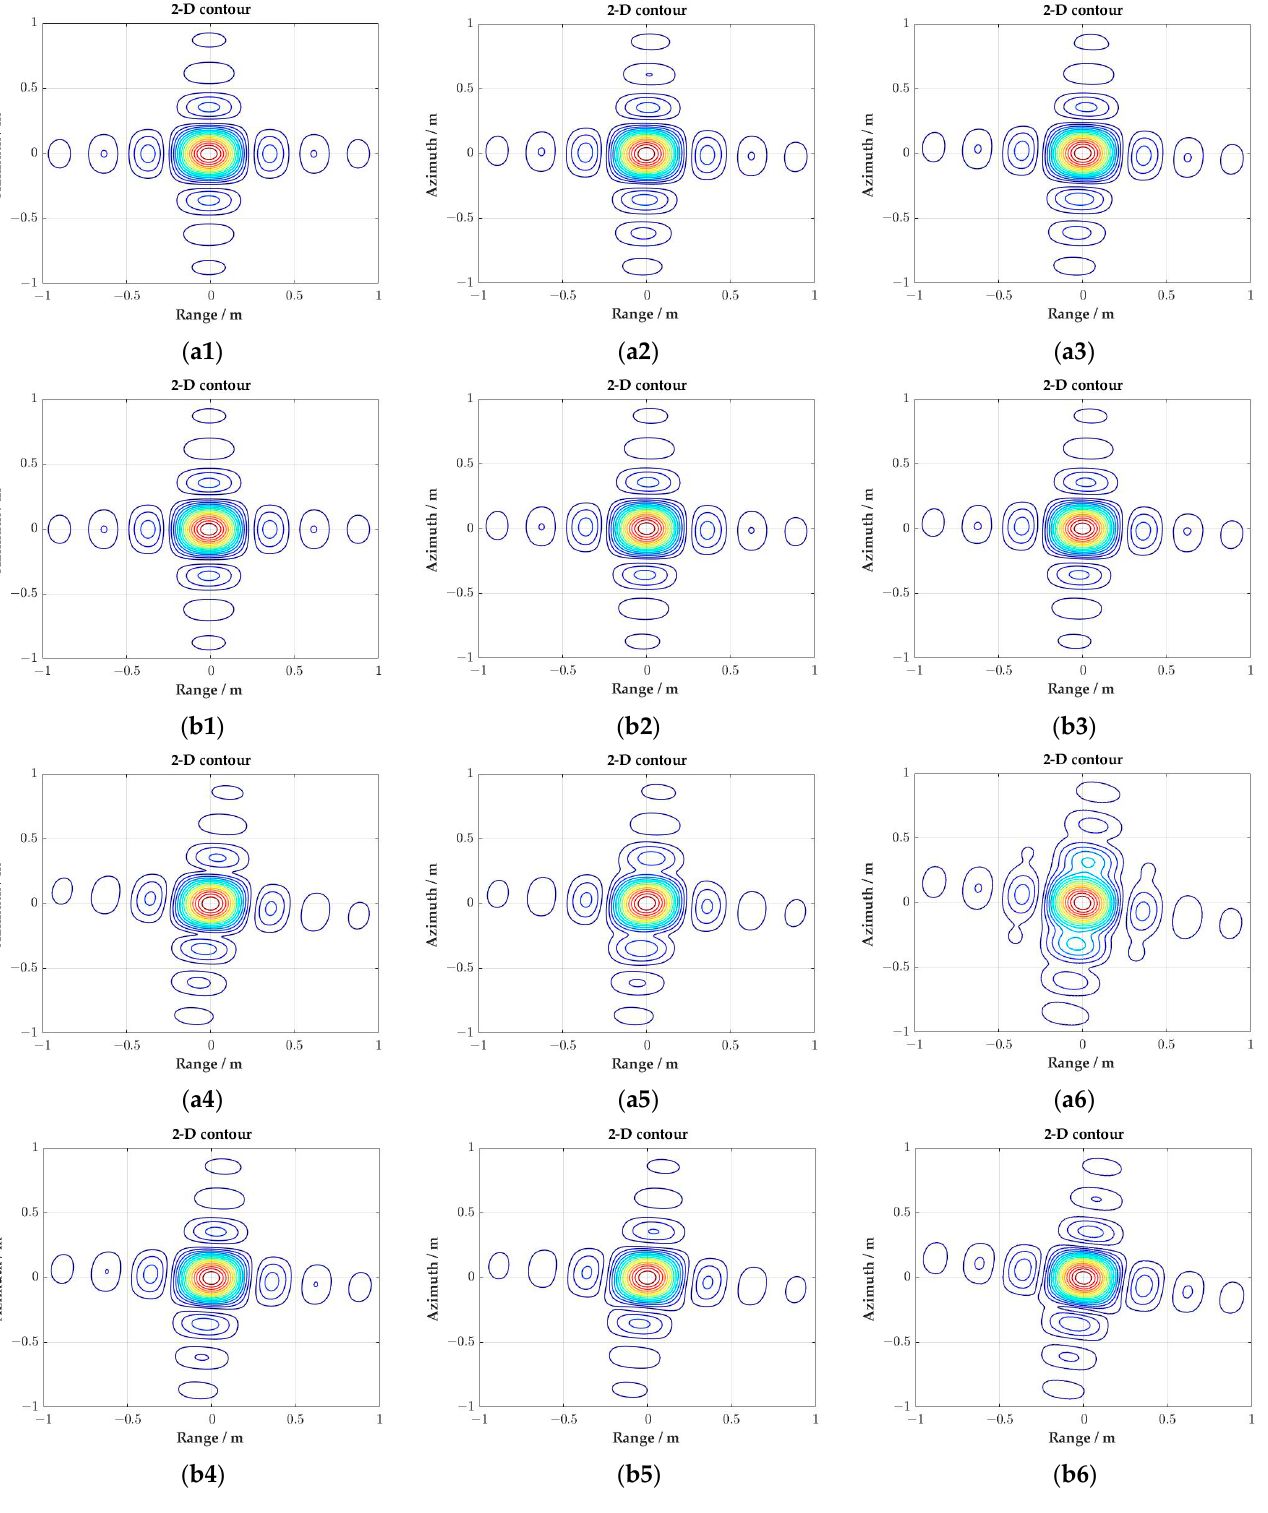
Figure 10. Evaluated results of azimuth two-dimensional contour for the chosen targets corresponding to 0.25 m azimuth resolution. ( a1 – a6 ) The results of Targets 17–22 before the Doppler phase perturbation. ( b1 – b6 ) The results of Targets 17–22 after the Doppler phase perturbation. All of the results have been up-sampled by 32× to better illustrate the details.